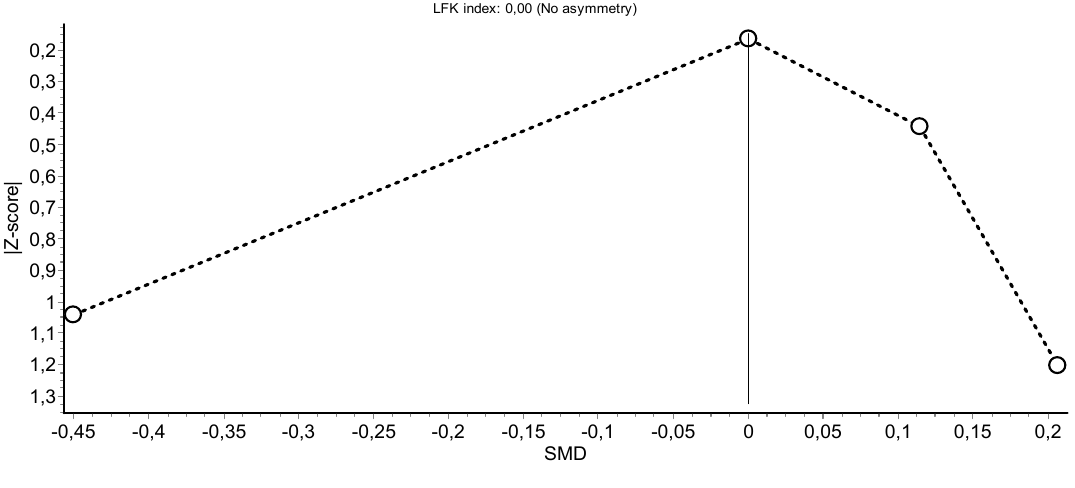
Figure A3. Synthesis funnel and Doi plot (LFK index) for resting heart rate.